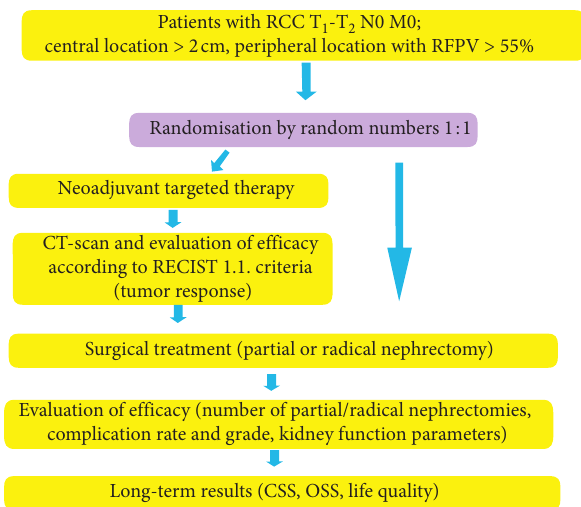
Figure 1: Efficacy of neoadjuvant targeted therapy in treatment of patients with localised clear-cell renal cell carcinoma study